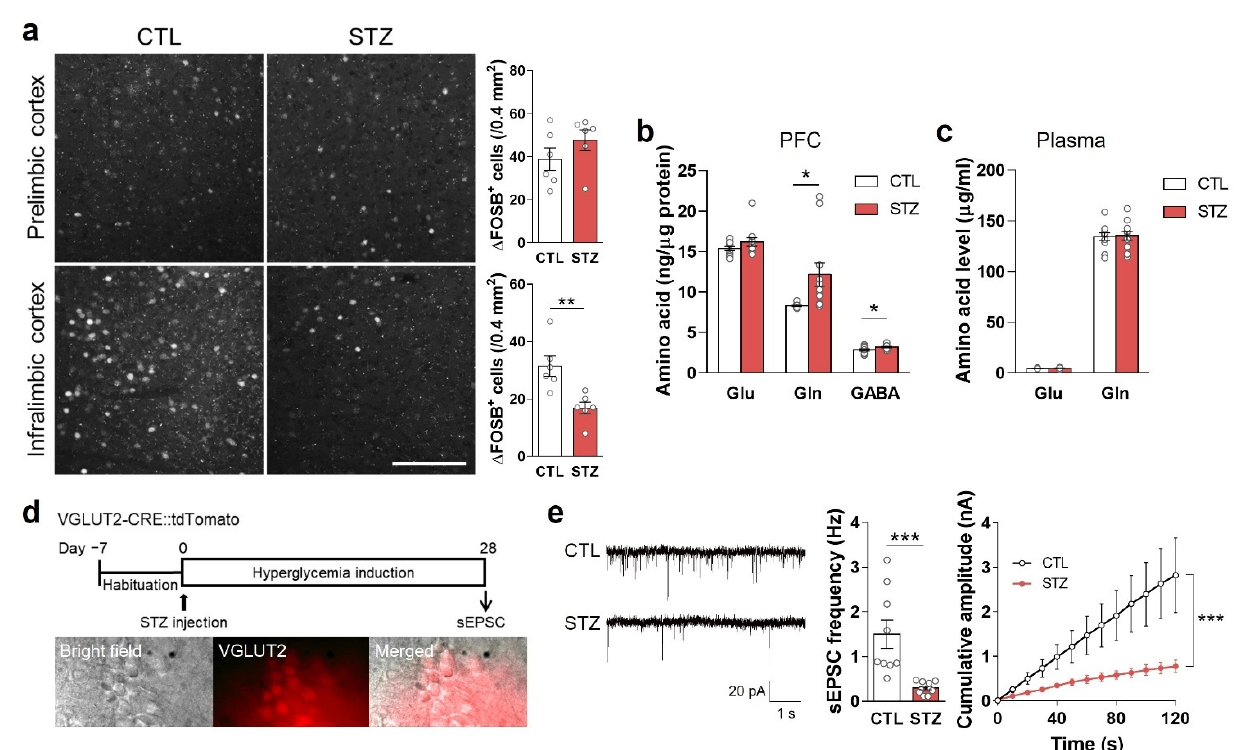
Figure 5. Hyperglycemia decreased glutamatergic neuronal activity. ( a ) Immunohistochemical analysis of ∆ FOSB in the prelimbic and infralimbic mPFC. The left panel shows representative images, and the right panel shows quantifications. Scale bar = 100 μ m. ( b , c ) Glutamate (Glu), glutamine (Gln), and γ -aminobutyric acid (GABA) levels in the PFC ( b ) and plasma ( c ) analyzed by LC-MS/MS. ( d ) Experimental design for electrophysiologic analysis and microscope images of spontaneous excitatory postsynaptic current (sEPSC) recording. sEPSC in the mPFC was measured 4 weeks after STZ injection in VGLUT2-CRE::tdTomato mice. ( e ) sEPSC and cumulative amplitude in glutamatergic neurons in the MPFC. n = 10/group (10 cells from 3 mice). Data are presented as mean ± SEM. * p < 0.05, ** p < 0.01, *** p < 0.001 between indicated groups according to Student’s t -test or two-way